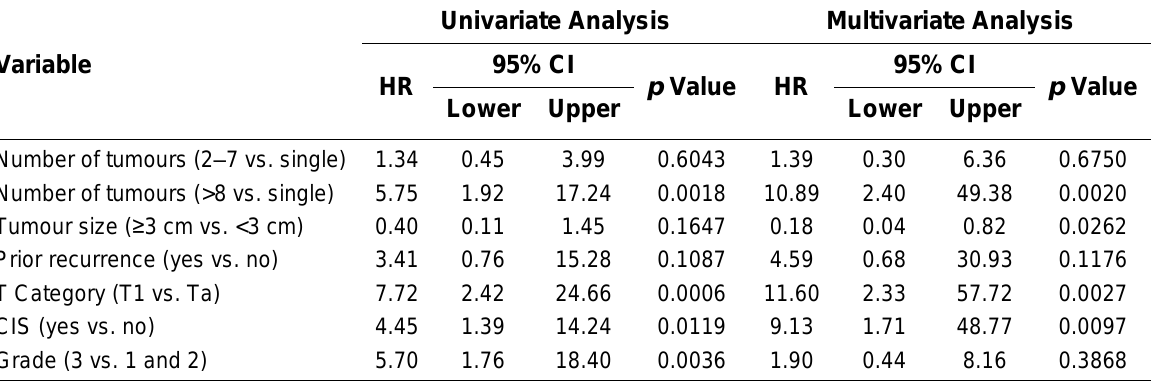
Cox Model Analysis of Time to Recurrence and